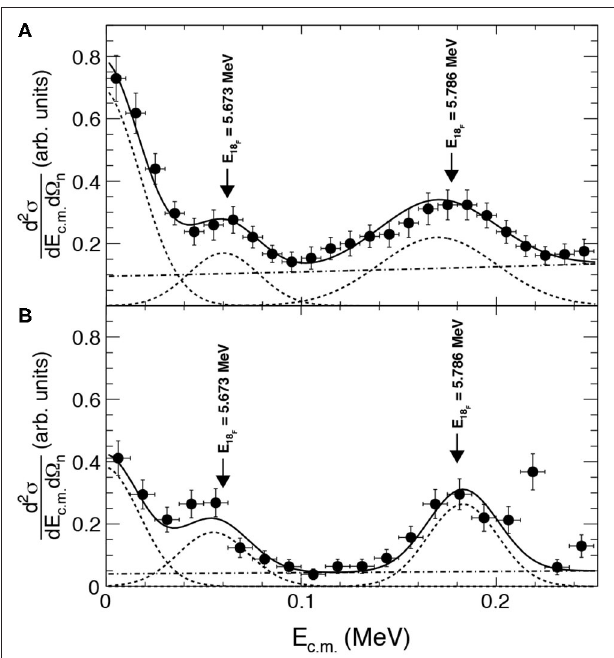
FIGURE 4 | Cross section of the 2 H( 17 O, α 14 N)n TH reaction (full circles) for the LNS (A) and NSL (B) experiments. See text for more details.